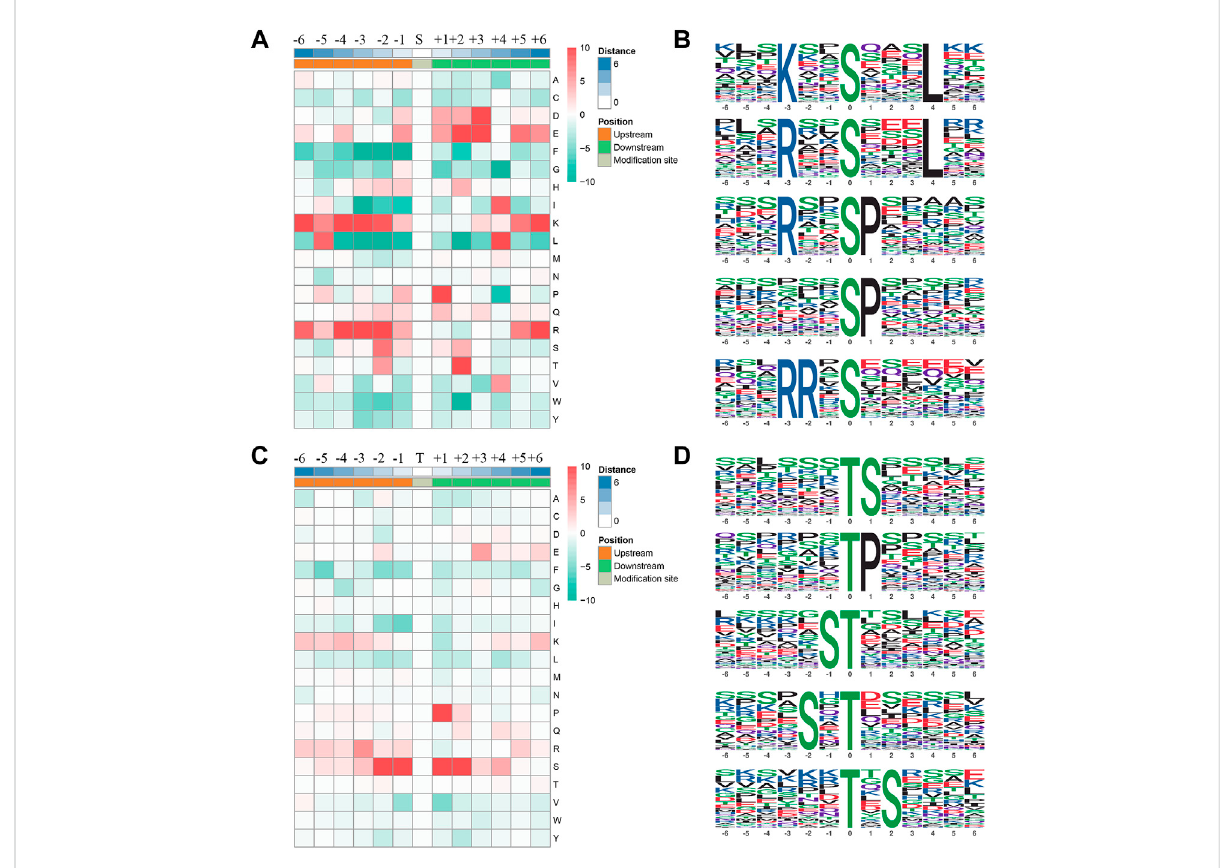
Phosphorylation site motifs. (A,C) The statistics of sequence probability in 6 phosphorylation site motifs with the prominent distribution of amino acid around serine and threonine phosphorylation sites. (B,D) Top fi ve serine and threonine phosphorylation motifs.